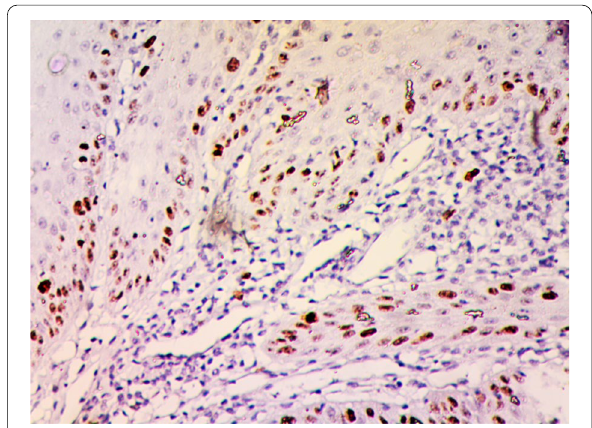
Fig. 4 Photomicrograph of Ki-67 immunoexpression showing intense immunostaining of basal and parabasal cells (